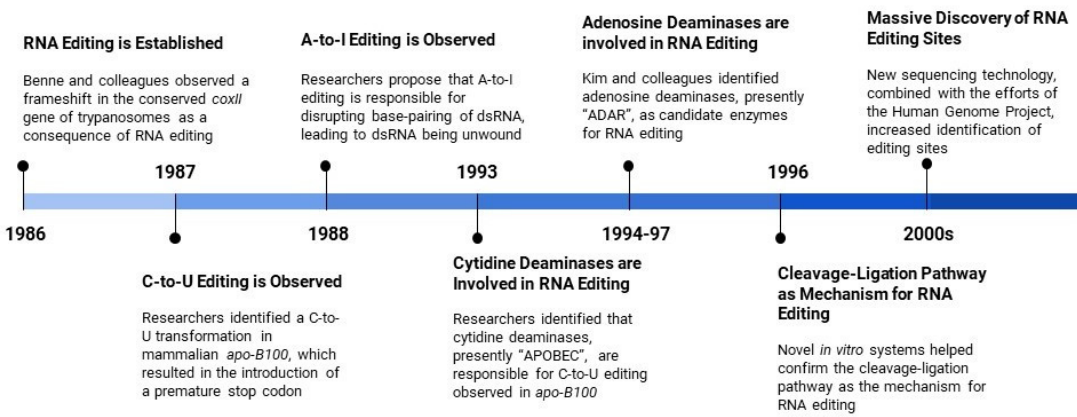
Figure 1. Milestones in RNA Editing Discovery.